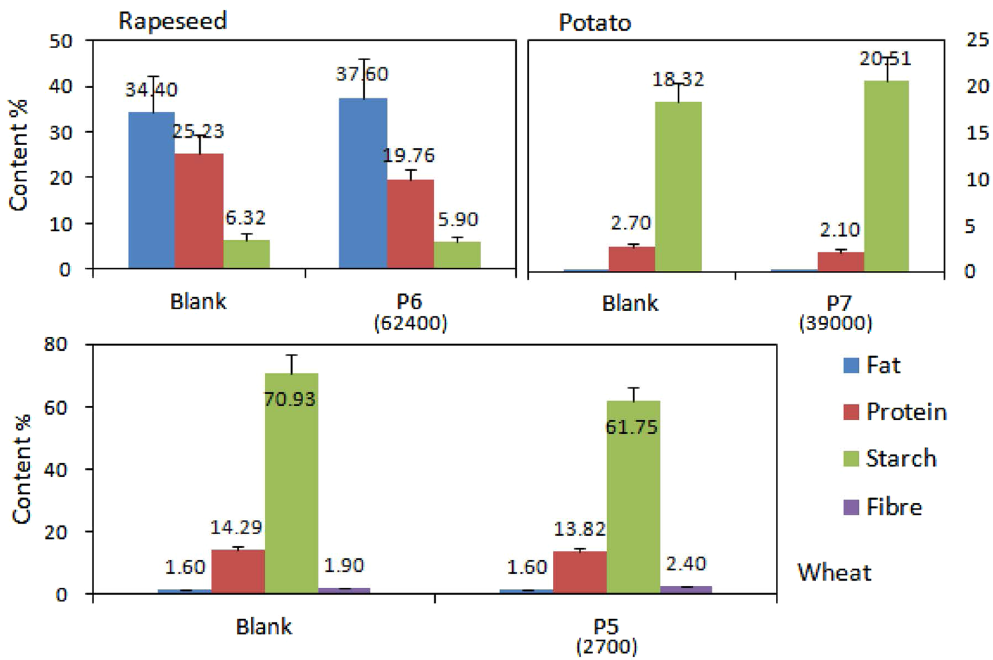
Figure 3. The effect of elevated CO 2 on quality of crop